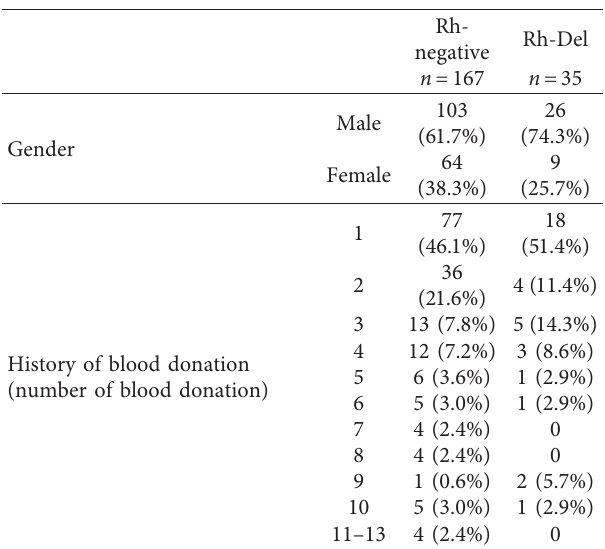
Table 4: Distribution of gender and blood donation number in Rh- negative and Rh-Del donors ( N � 202).